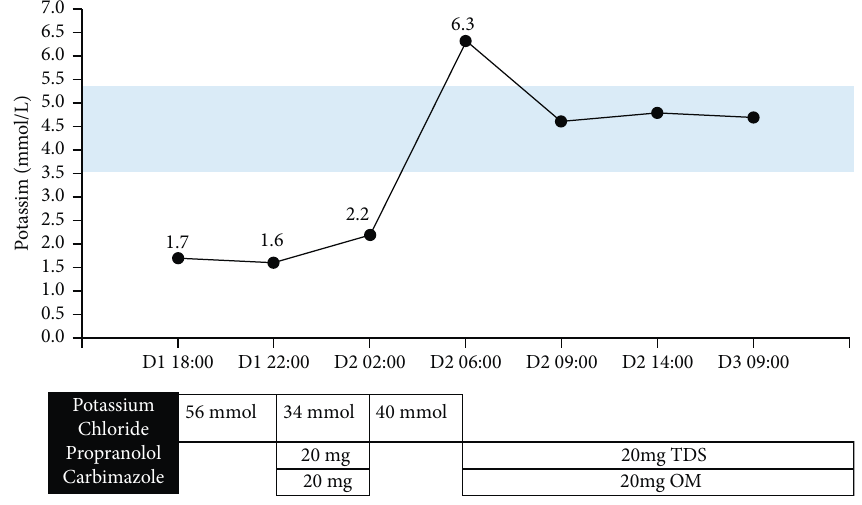
Figure 2: Serum potassium